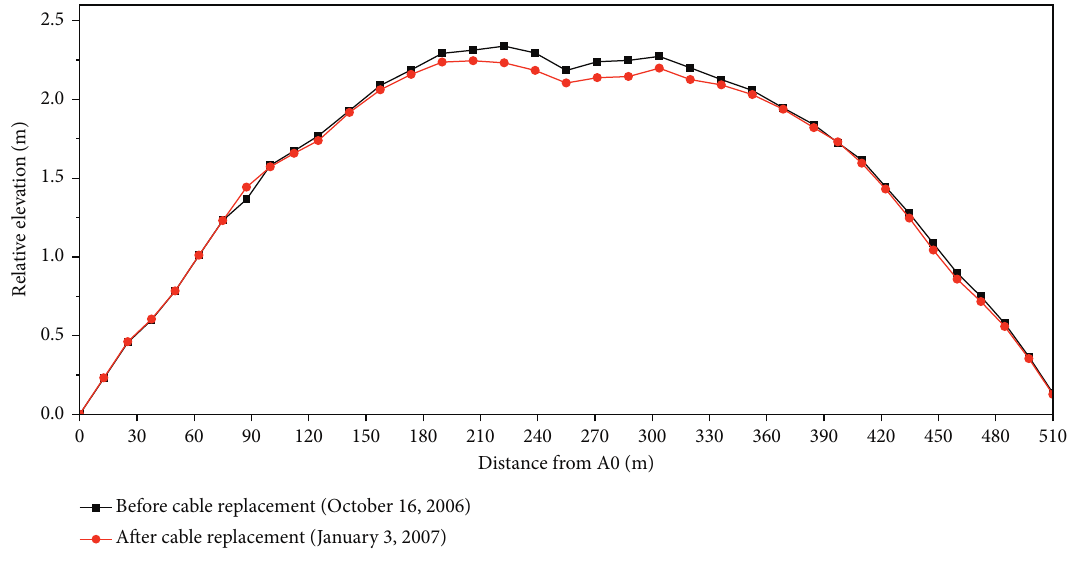
Figure 11: Geometry profiles of bridge deck before and after cable